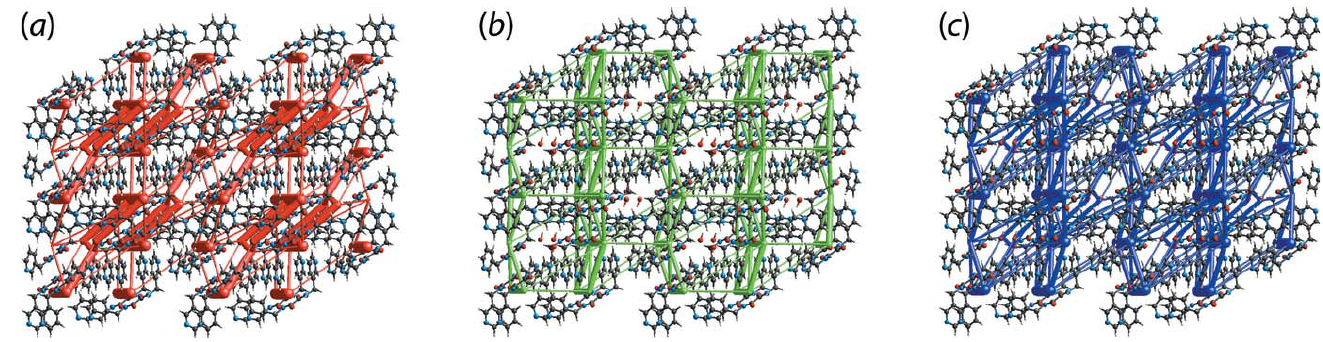
Figure 6 Perspective views of the energy framework of (I), showing the ( a ) electrostatic force, ( b ) dispersion force and ( c ) total energy diagram. The cylindrical radius is proportional to the relative strength of the corresponding energies and they were adjusted to the same scale factor of 100 with a cut-off value of 8 kJ mol (cid:5) 1 within 2 (cid:7) 1 (cid:7) 2 unit cells.